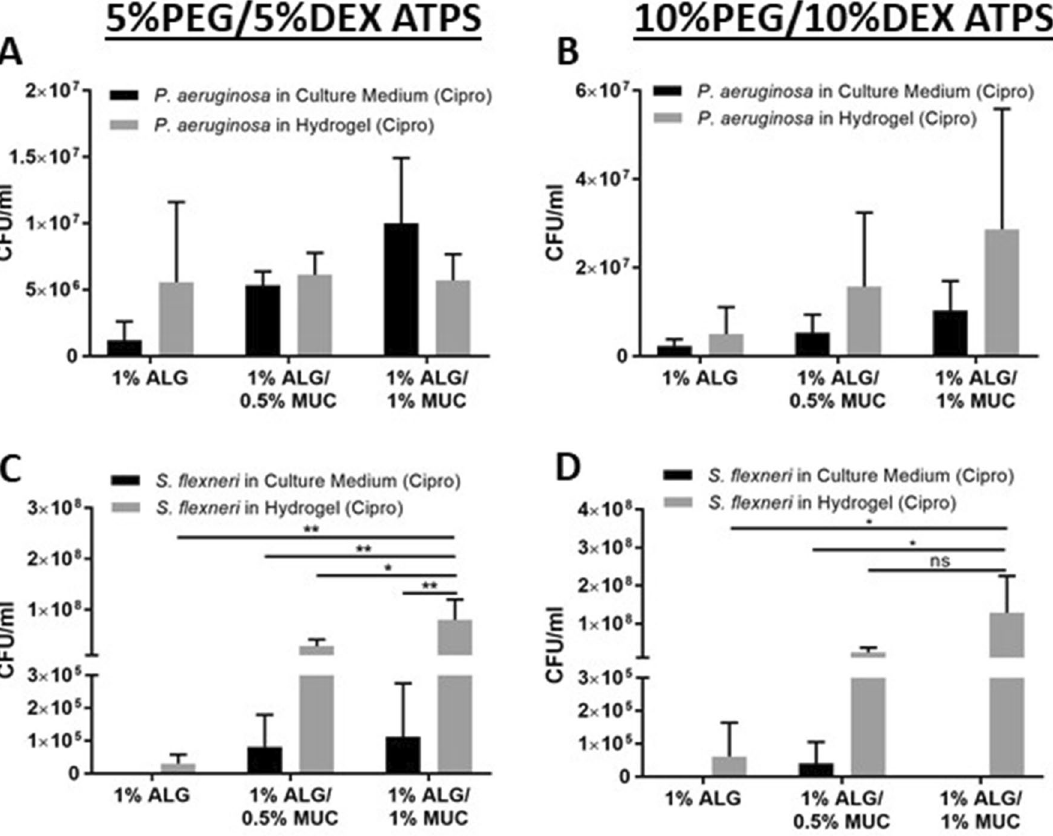
Figure 2. P. aeruginosa and S. flexneri abundance (CFU/ml) within the culture medium or hydrogel layer after 12 h of co-culture with 16-HBE and Caco-2, respectively, where PEG-phase media was supplemented with ciprofloxacin (0.125 μg/ml). CFU/ml values were calculated from P. aeruginosa grown in either a 5%PEG/5%DEX ATPS ( A ) or 10%PEG/10%DEX ATPS ( B ), and S. flexneri in a 5%PEG/5%DEX ATPS ( C ) or 10%PEG/10%DEX ATPS ( D ), where *indicates p < 0.05, **indicates p < 0.01, and ns = non-significant (n = (Fig. 5A,B). The resulting cell viability, after 48 h of incubation, demonstrated that all hydrogel formulations were able to significantly reduce cell death, under 5% and 10% PEG-phase conditions compared to when no hydrogel was present (Fig. 5A).